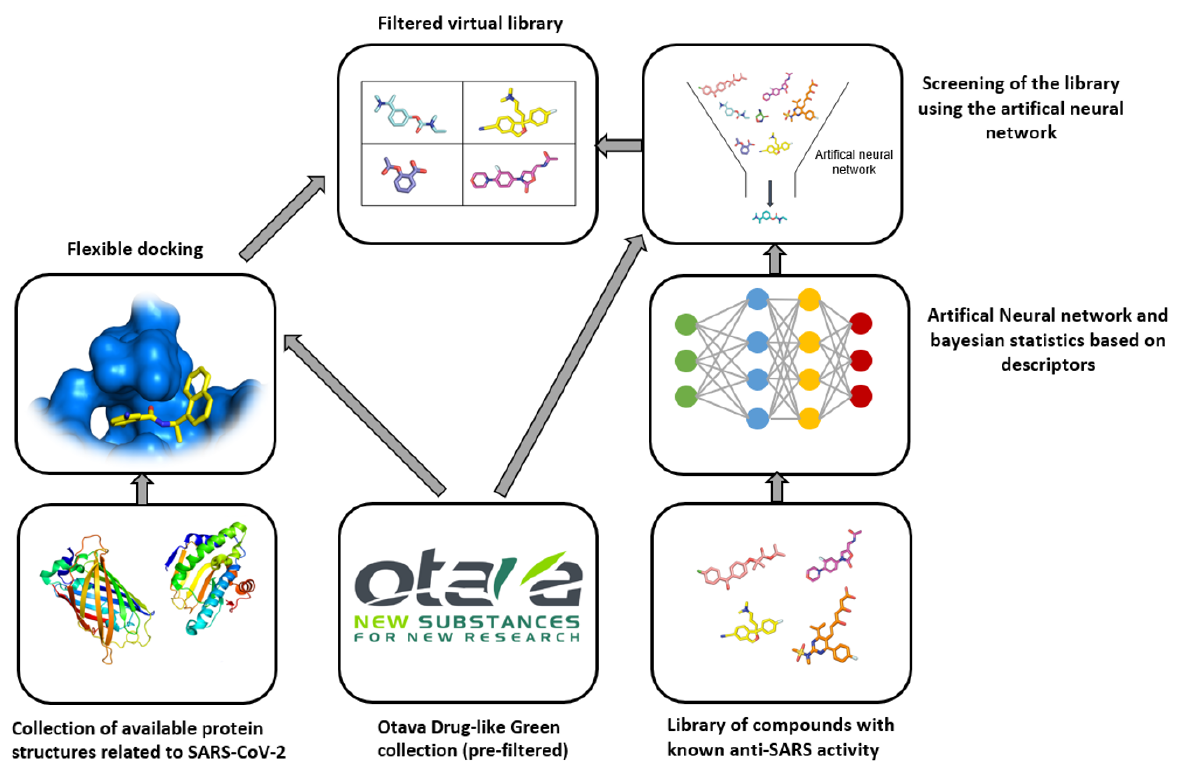
Figure 4. Process algorithm for generating the Otava ltd. SARS-CoV-2-targeted molecular library.